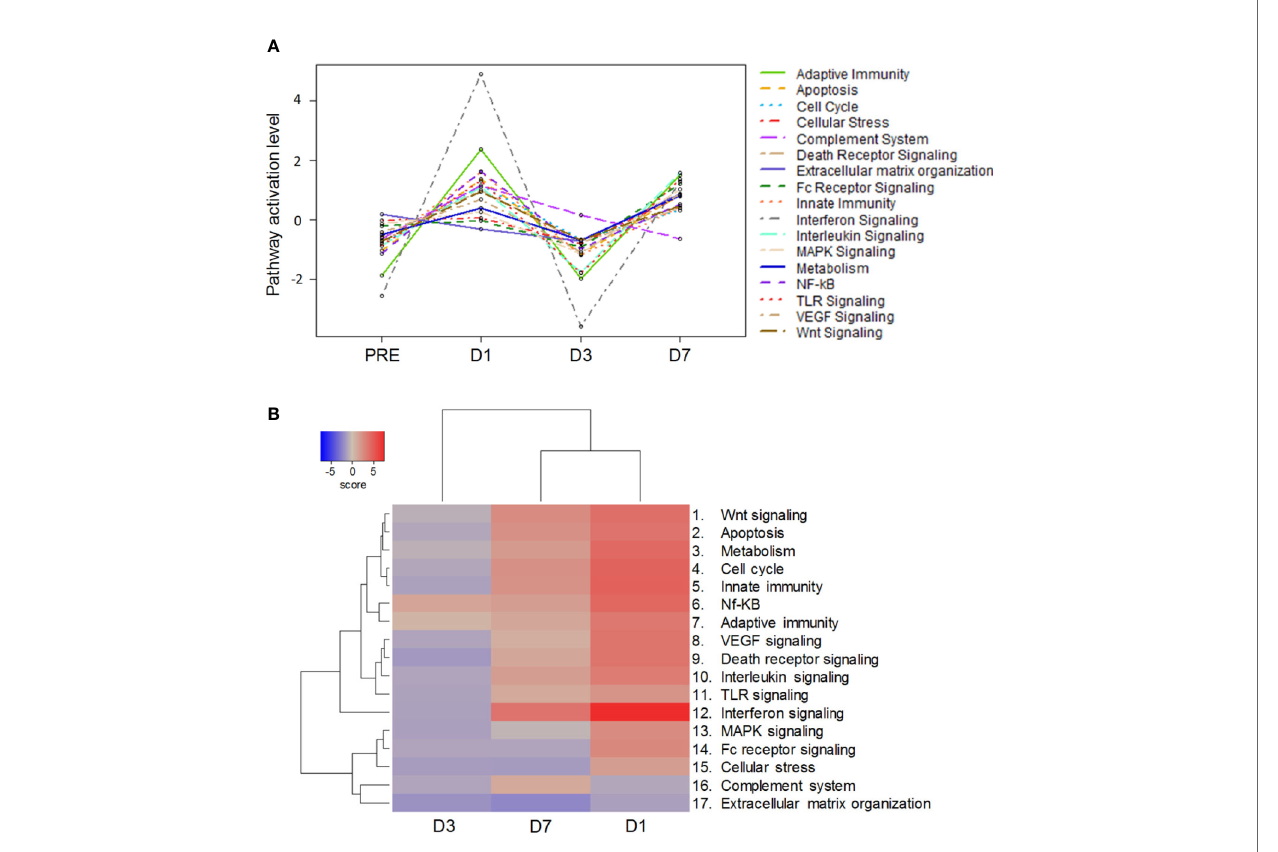
FIGURE 6 | Bimodal kinetic pattern of gene signatures in ChAd155-RG-immunized macaques. Whole blood was collected at pre-vaccination ( “ PRE ” ) and 1, 3 and 7 days post vaccination (D1, D3, D7) from six macaques injected intramuscularly with ChAd155-RG rabies vaccine (5 × 10 10 vp) at Day 0. Modulation of gene expression across timepoints was analyzed through pathway scoring (A) and gene set analysis (B) , with both methods leading to analysis of pathway modulation at the different timepoints. Signi fi cantly enriched immune-related pathways are listed at the right side of each panel (see Table S2 for gene lists per pathway). (A) For pathway scoring, principal component (PC) analysis was performed for each sample using a linear combination (weighted average) of its gene expression values, weighing speci fi c genes to capture the greatest possible variability in the data. The fi rst PC re fl ects any factor(s) emerging as main driver(s) of variability in gene expression of that particular gene set. (B) Gene expression values were expressed as log 2 fold-changes over baseline ( P -value < 0.05). Differential expression and pathway enrichment analyses were performed by direct global signi fi cance analyses using NanoString nSolver 4.0 with Advanced Analysis 2.0 plugin (730-gene